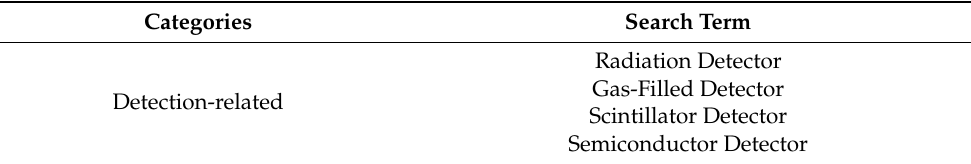
Table 1. The search term used in this review.